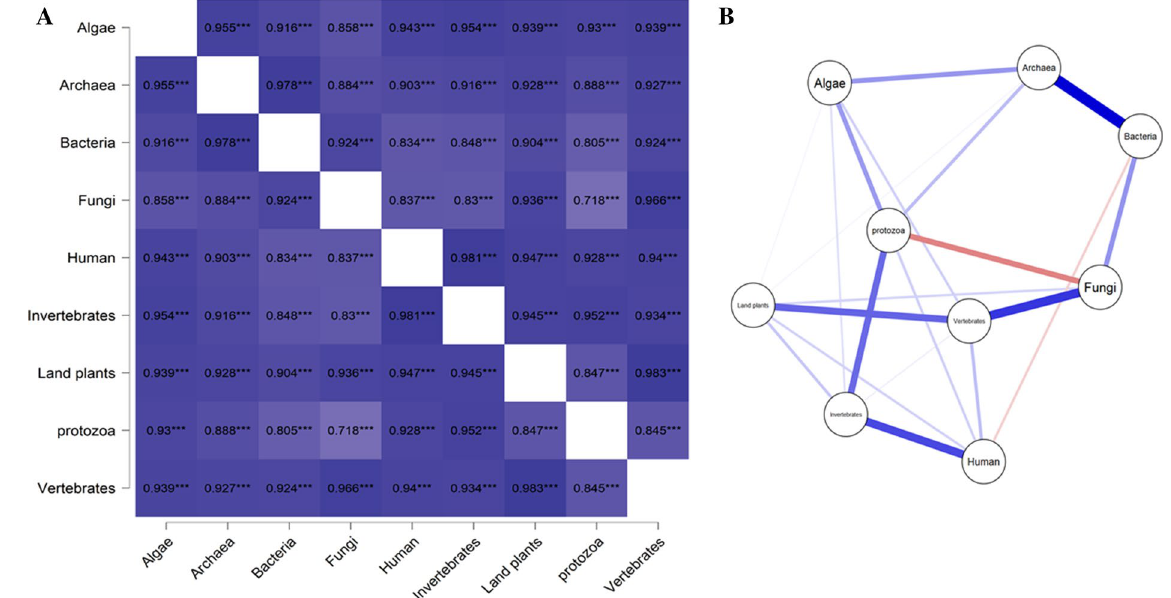
Figure 3. ( A ) Heatmap and ( B ) network plot of the amino acid composition of the virus proteome originated from different hosts. Heatmap shows, maximum of the virus protein shows a positive correlation on its amino acid composition. The highest positive correlation was found between the virus proteome of bacteria and archaea (0.978) whereas the lowest correlation was found between virus proteome originated from fungi and protozoa (0.718). The dark blue mark indicates the highest and the red mark indicates the lowest correlation. Pearson’s correlation study was conducted to construct the correlation plot (p < 0.05).